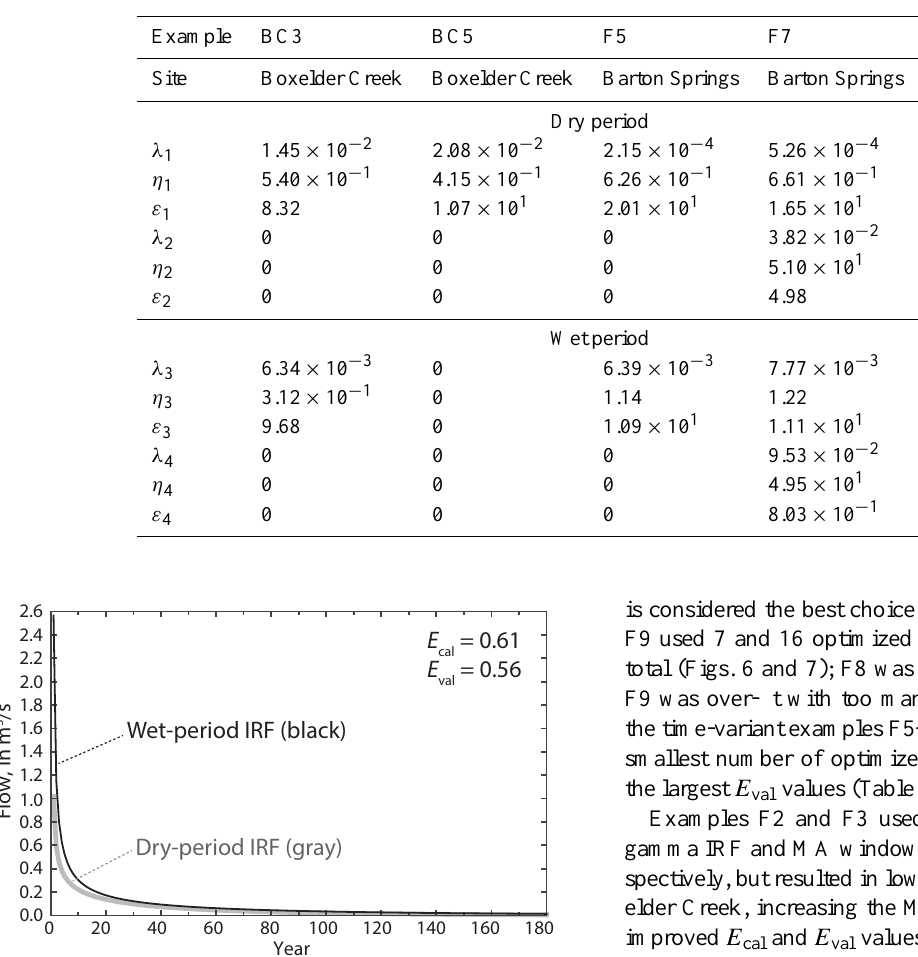
Table 3. Impulse-response function parameters for selected example models.